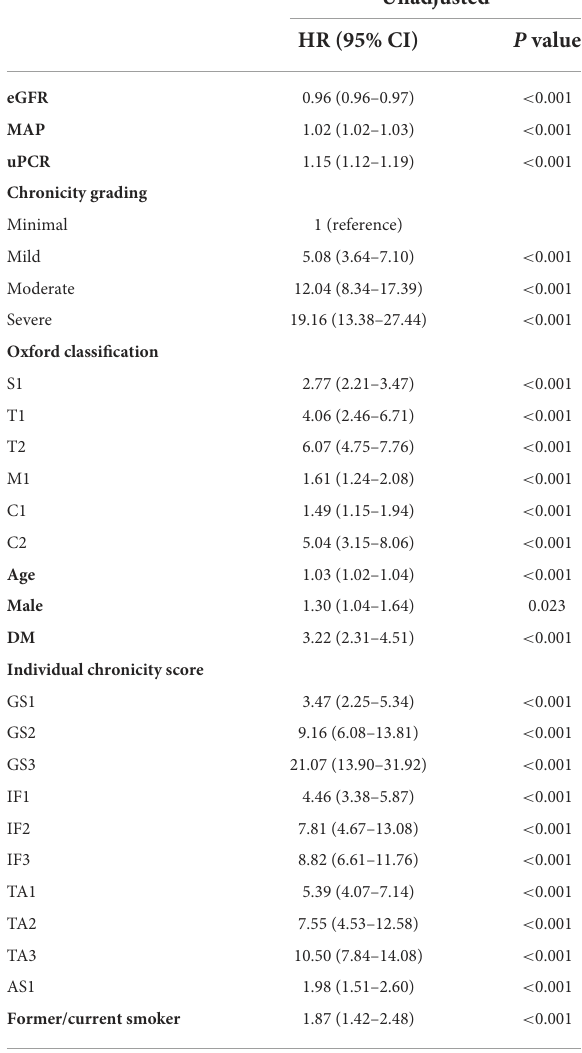
TABLE 5 Univariate Cox regression analysis with ESRD